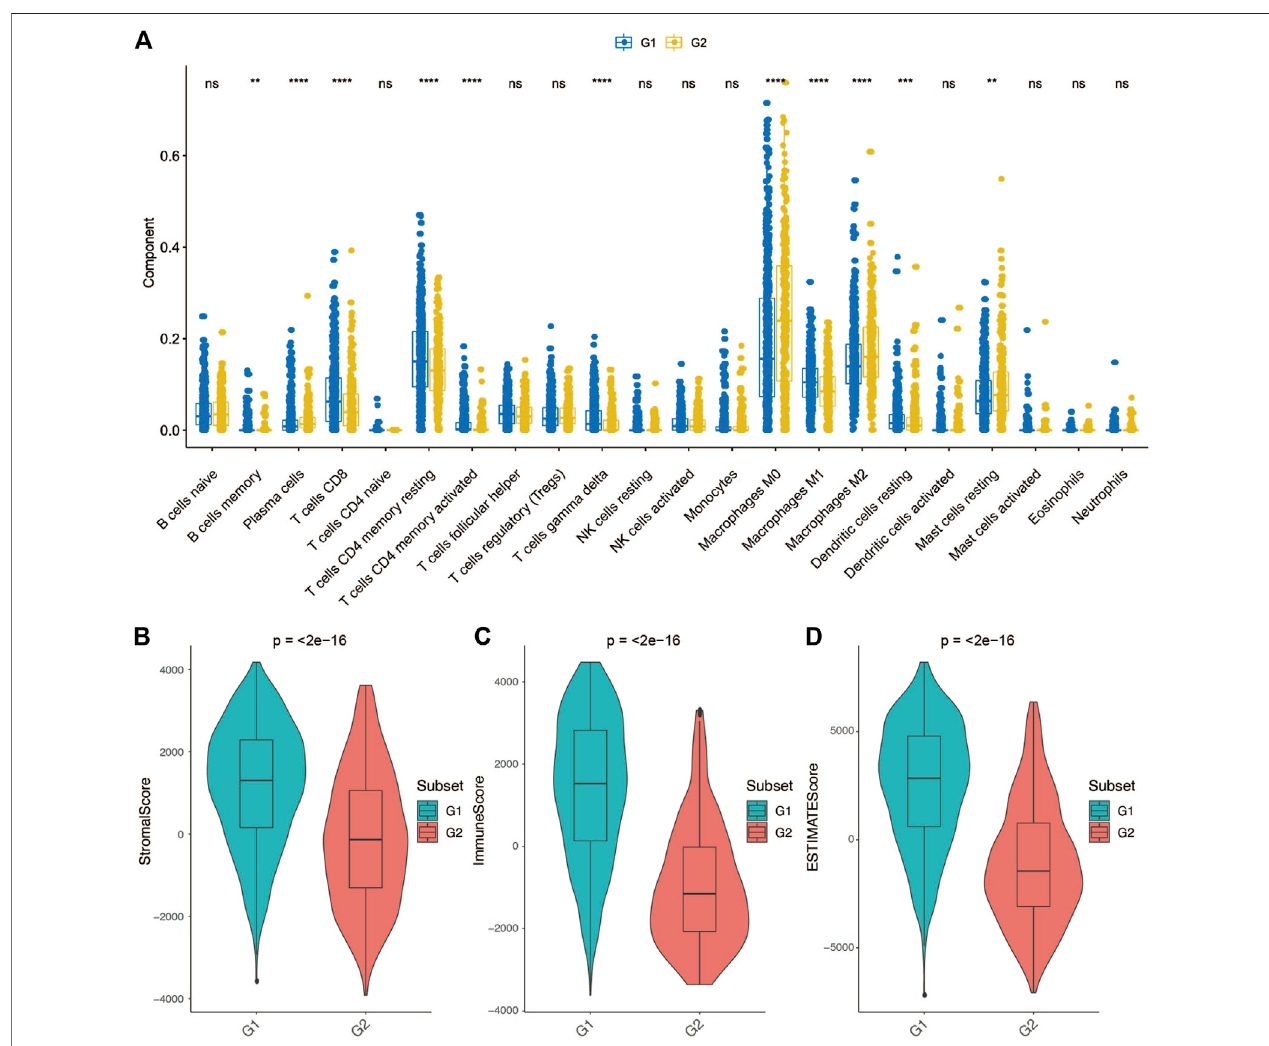
FIGURE 5 | Tumor microenvironment differences between group 2 (G2) and group 1 (G1) subgroups. (A) Comparison of each immune cell component between G1andG2. (B) Comparison ofstromascorebetweenG1andG2. (C) ComparisonofimmunescorebetweenG1andG2. (D) ComparisonofESTIMATEscorebetween G1 and